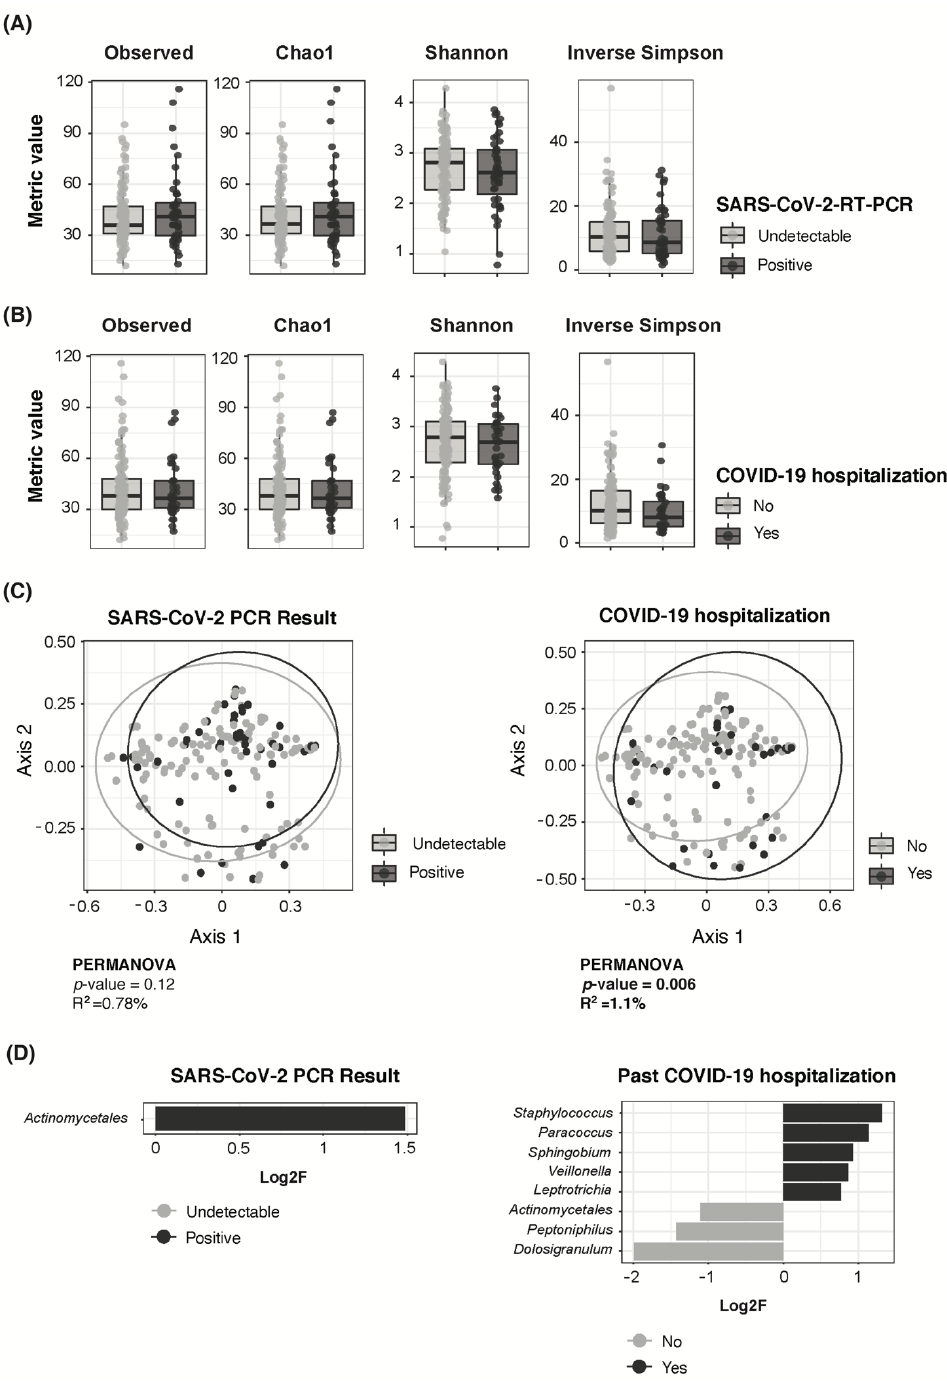
Figure 4. Nasopharyngeal microbiota composition in adults according to SARS-CoV-2 RNA persis- tence and COVID-19 severity. ( A ) Boxplots showing richness (Observed and Chao 1) and diversity (Shannon and Inverse Simpson) metrics between SARS-CoV-2 RNA persistence groups in adults. ( B ) Boxplots showing richness (Observed and Chao 1) and diversity (Shannon and Inverse Simpson) metrics by history of COVID-19-related hospitalization in adults. ( C ) PCoA ordination analysis on Bray–Curtis ecological distance matrix showing distribution of SARS-CoV-2 positive and negative adult samples on the left, and by history of COVID-19 hospitalization on the right. ( D ) Differen- tial abundance analysis on bacterial genera by SARS-CoV-2 RNA persistence (left) or by history of COVID-19-related hospitalization (right). Log2F is shown along the X -axis and differential genera are colored based on the group they relate